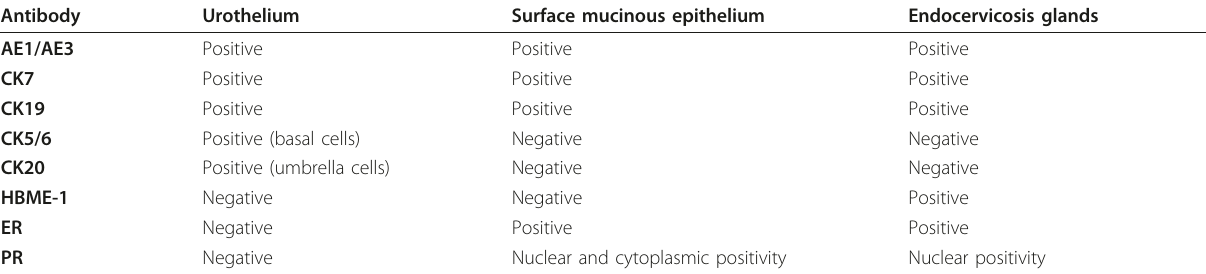
Table 1 Antibody expressions in urothelium, surface mucinous epithelium and endocervicosis glands